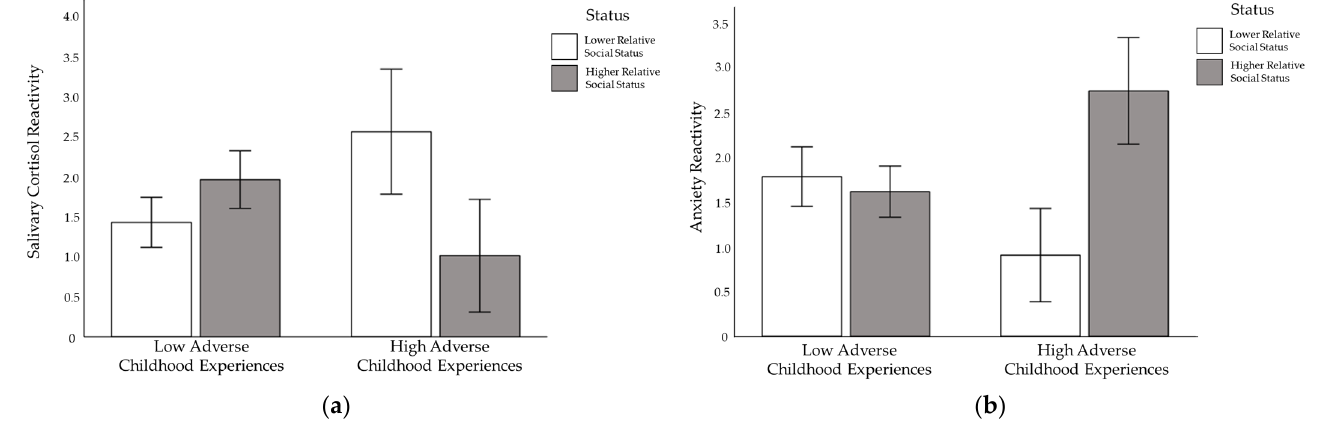
Figure 2. The Interaction of Early Adverse Experiences and Relative Social Status on ( a ) Salivary Cortisol Reactivity and ( b ) Anxiety Reactivity. Note. Bars represent 1 standard error.